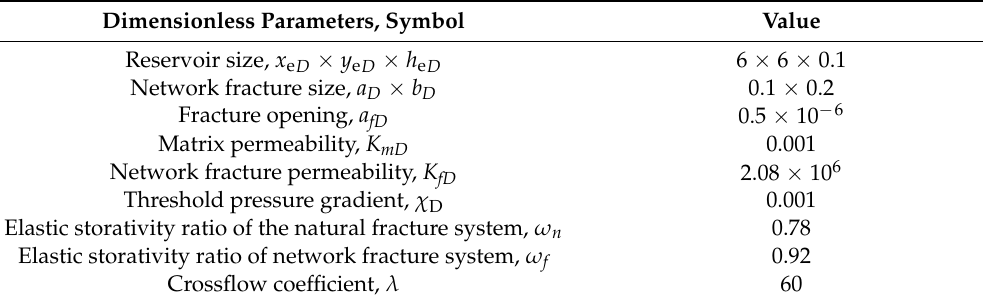
Table 2. Dimensionless variables used for the analysis and discussion of the